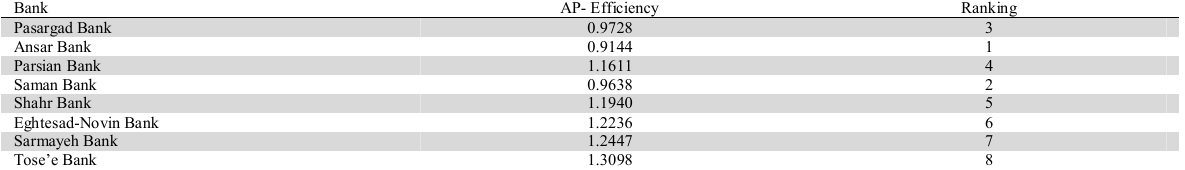
Ranking of customer satisfaction index efficiency, output-orientated AP model